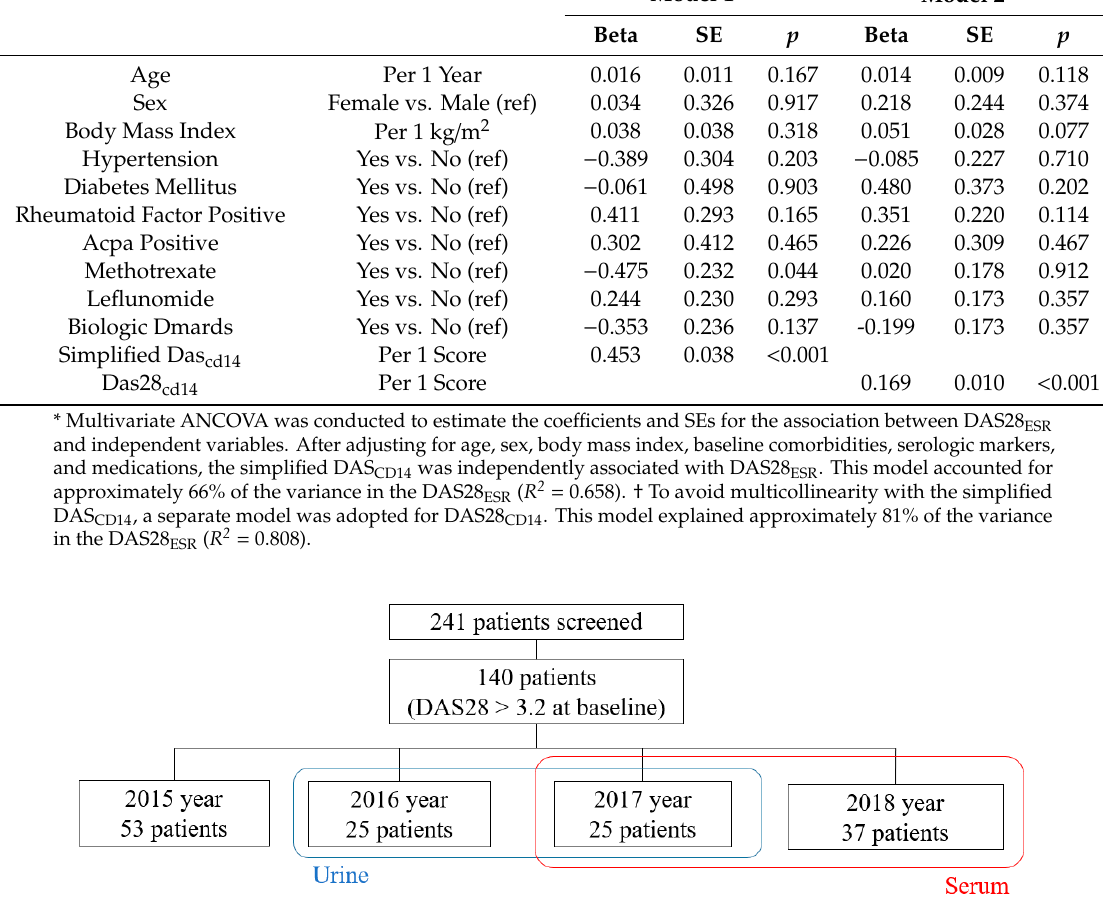
Figure A2. Comparison of urinary sCD14 concentrations measured by the FREND™ system with RA disease activity and treatment outcome. ( A ) Linear correlation between urinary sCD14 and the DAS28 ESR . ( B ) ROC curve analysis of urinary sCD14 versus CRP levels for differentiating low RA activity from moderate-to-high RA activity. Two AUCs were compared using two-sided statistical tests and p -values were calculated. ( C ) Urinary sCD14 levels according to EULAR treatment response, and ( D ) ROC curve analysis of Δ urinary sCD14 (sCD14 level at baseline to the sCD14 level at 6 months after treatment with anti-rheumatic drugs) for differentiating good responders from moderate-to-no responders. The AUC value for changes in CRP ( Δ CRP) is shown for comparison. Two AUCs were compared, and the p -value does not indicate a significant difference between them.